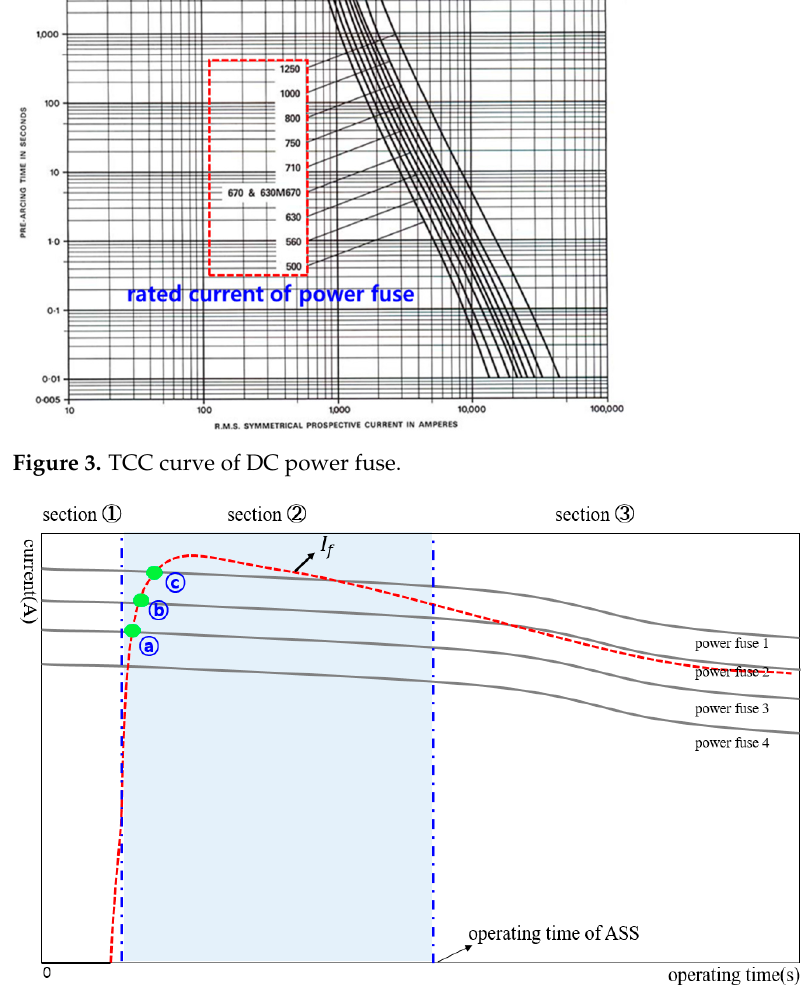
Figure 3. TCC curve of DC power fuse.